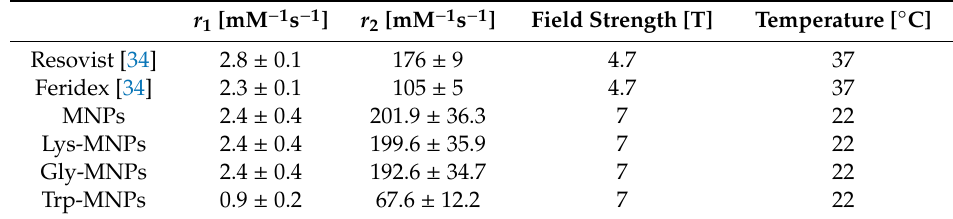
Table 4. Relaxivities’ comparison of our AA–MNP complexes and commercially available contrast agents based on the iron oxide nanoparticles (IONPs).